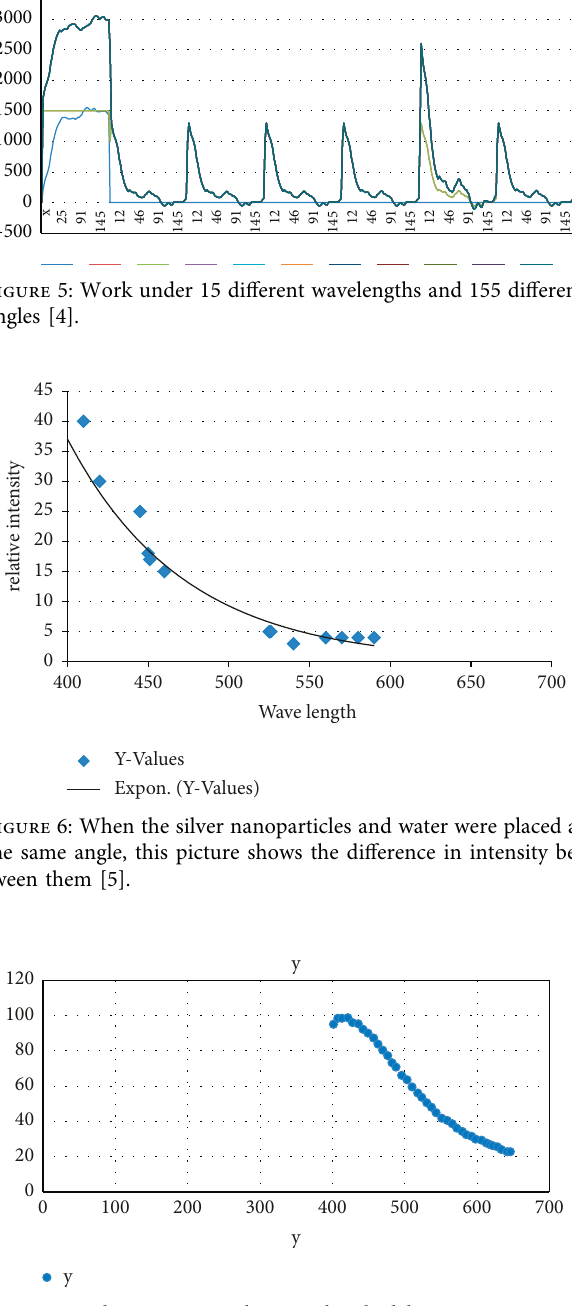
Figure 7: Silver nanoparticles are absorbed by a UV-Vis spec- trophotometer that has been calibrated [7].